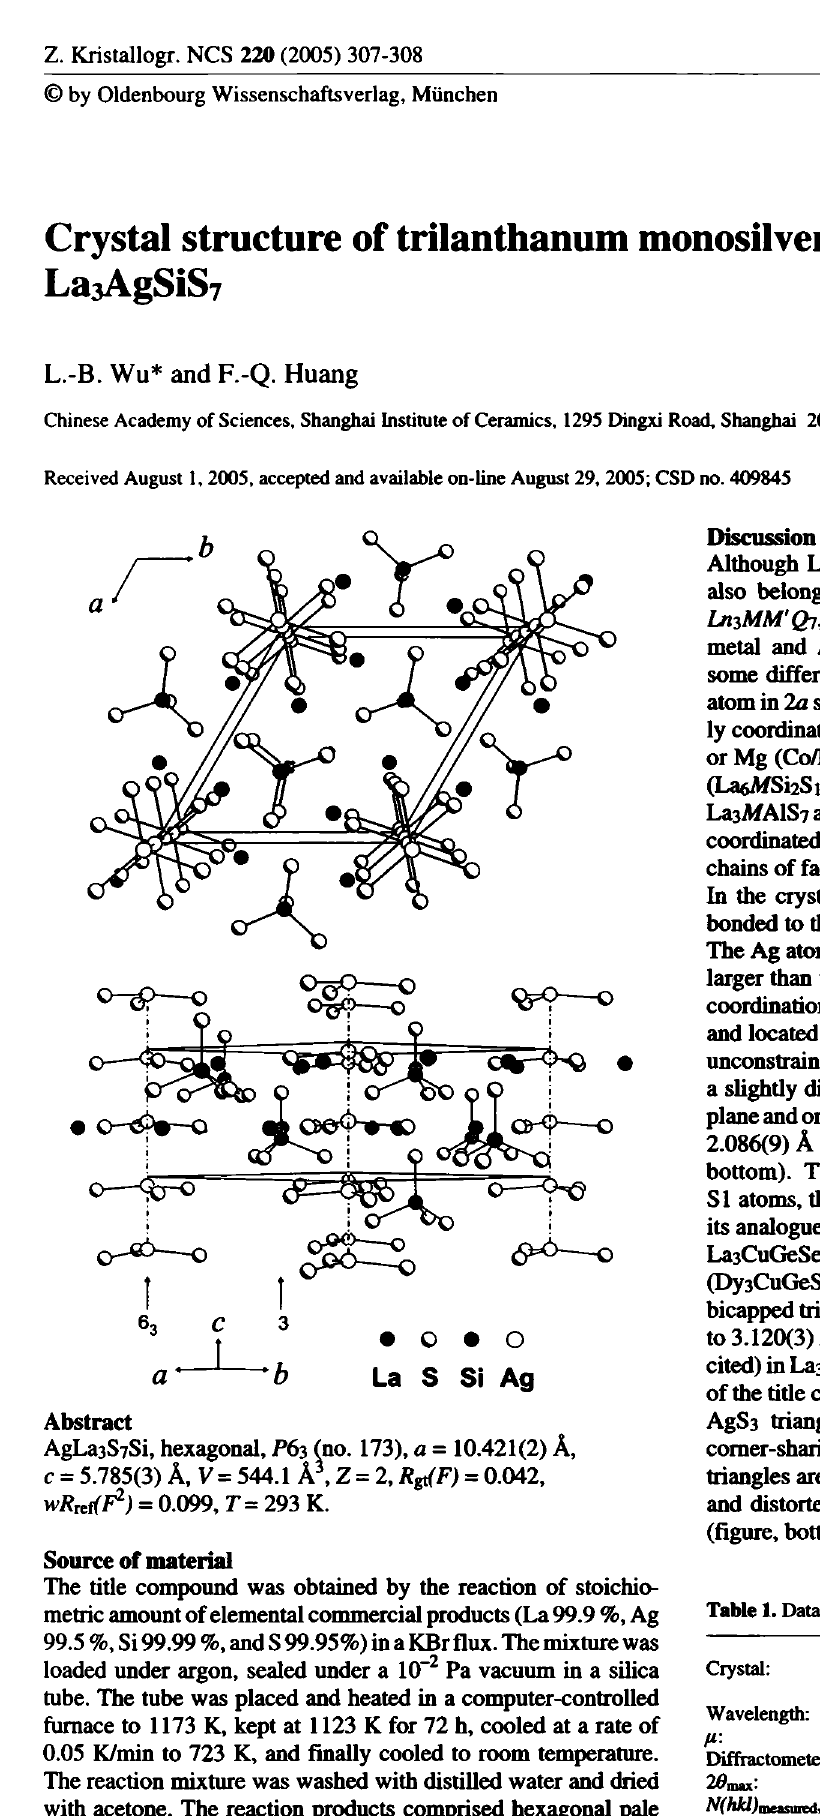
Table 1. Data collection and